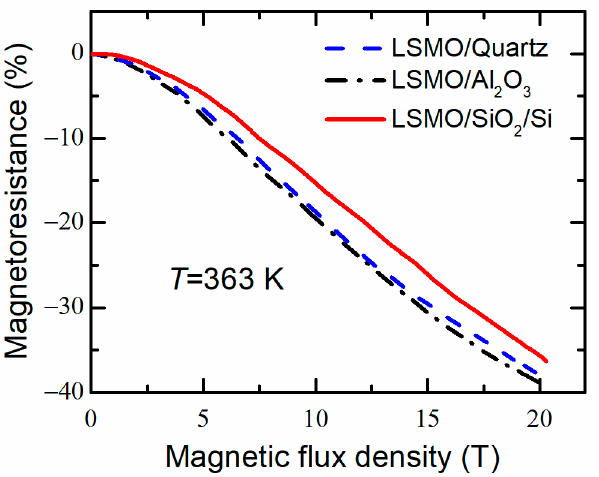
Figure 13. Magnetoresistance dependences on magnetic flux density at T = 363 K for 360 nm thick films grown on quartz, Al 2 O 3 and Si/SiO 2 substrates.